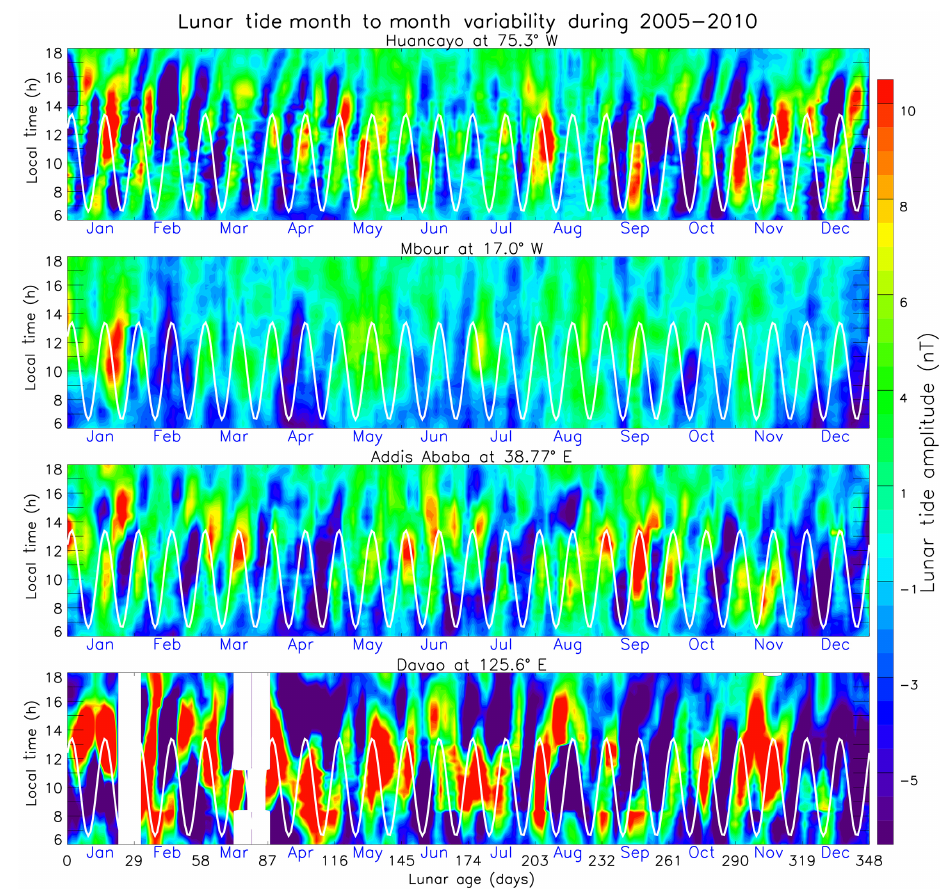
Figure 4. Month-to-month (January–December) variability in the lunar tide influence on EEJ observed at four different longitudes (shown at the top of each panel) over the course of solar minimum period (2005–2010). The overplotted white curves represents the standard component of the lunar tide variation at local noon obtained from Eq. (1), showing quite remarkable agreement with observations performed at four different